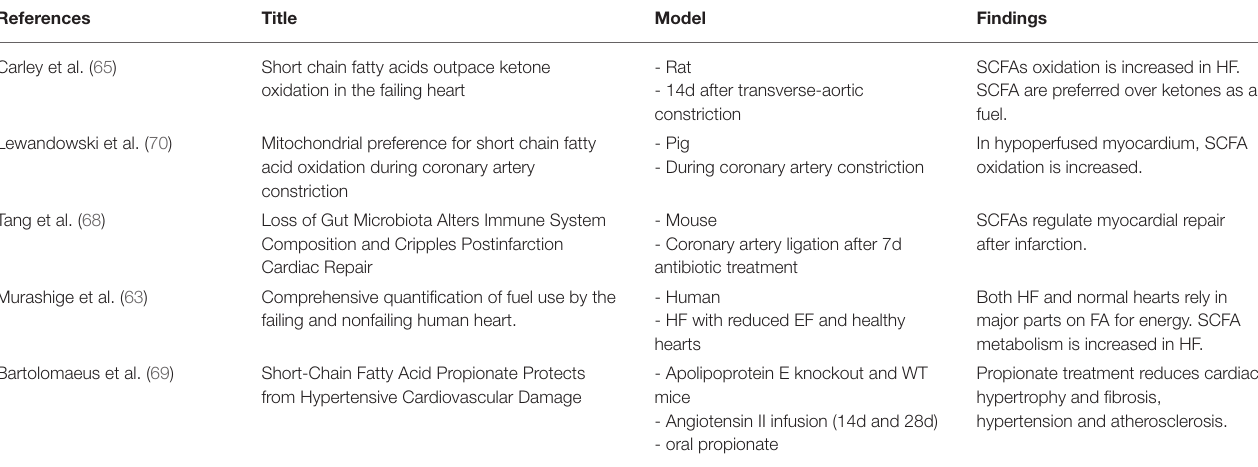
TABLE 2 | Studies investigating the role of SCFAs in cardiovascular